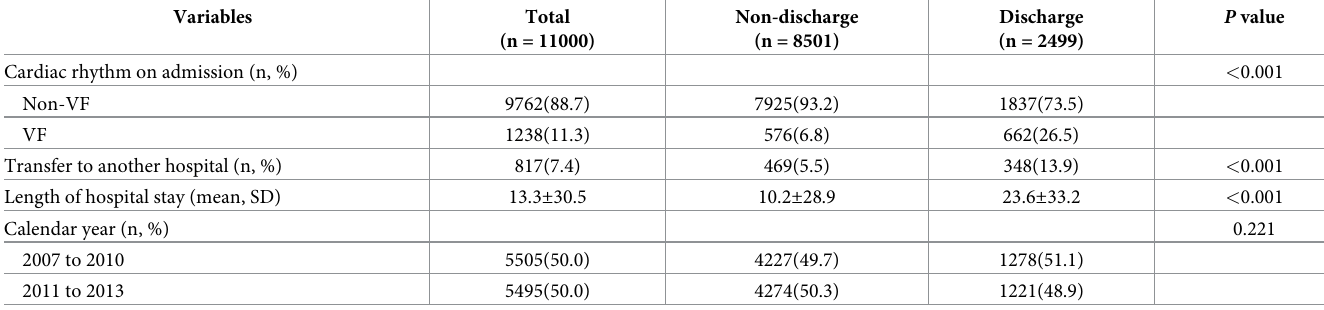
Table 3. Event characteristics of hospitalized OHCA